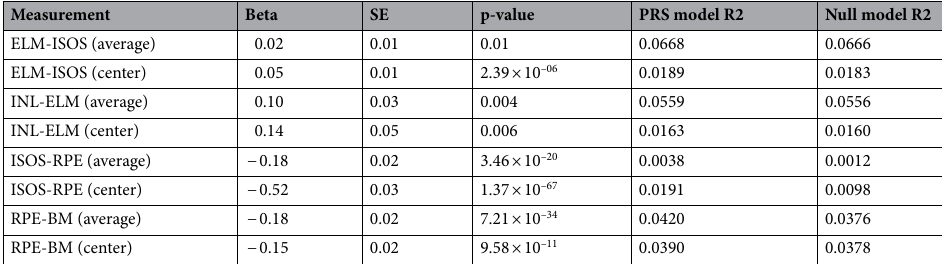
Table 3. SD-OCT variance predicted by a model adjusted by for sex, age, spherical equivalent, smoking status and polygenic risk score (PRS). The model included SD-OCT measurements as dependent variables and PRS as an independent predictor. PRS was calculated using 33 AMD-associated variants. Columns “Beta”, “SE” and “p-value” show the changes in the measurements per standard deviation in PRS dosage increase, and standard errors and p-values of the associations. Fields “R 2 (Null model)”, “R 2 (Model adjusted for PRS)” and “R2 difference” include R 2 of the null model, adjusted for sex, age, spherical equivalent and smoking status, and the model additionally adjusted for PRS, and the R 2 difference between null model and the model adjusted for